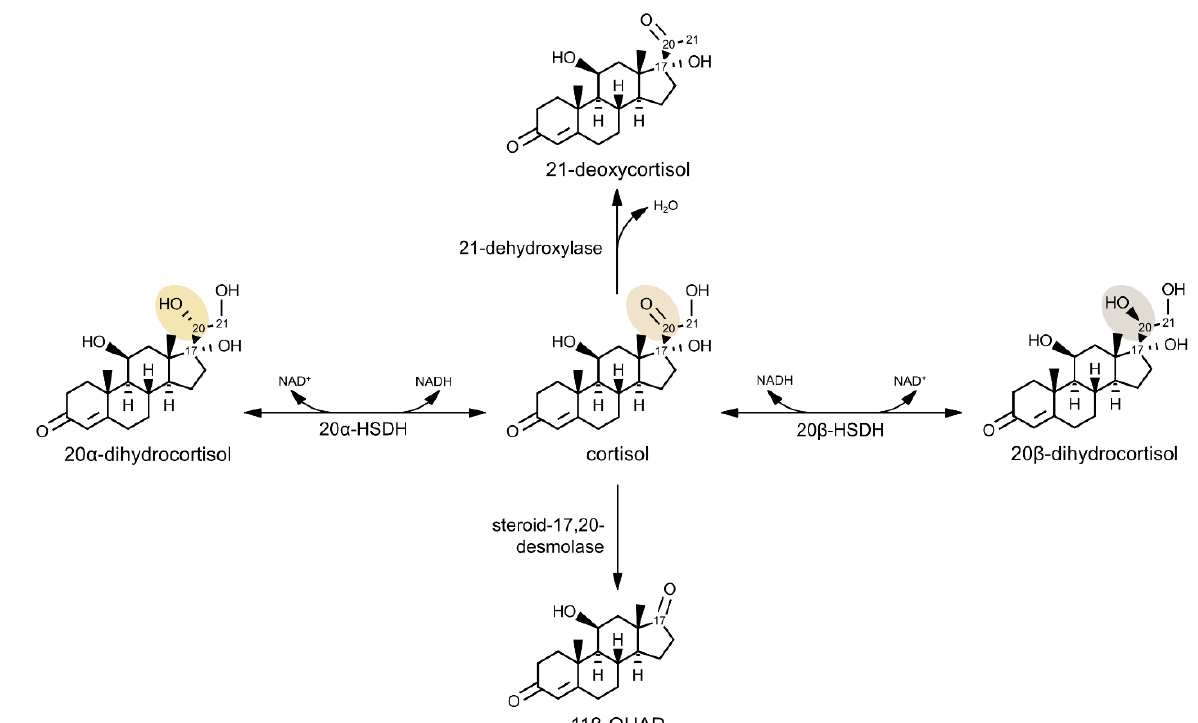
Figure 5. Microbial cortisol hydroxysteroid dehydrogenase metabolism. Cortisol can be reversibly biotransformed by 20β-hydroxysteroid dehydrogenase (20β-HSDH; DesE) to 20β-dihydrocortisol, or by 20α-HSDH (DesC) to 20α-dihydrocortisol. Steroid-17,20-desmolase (DesAB) converts cortisol to 11β-hydroxyandrostenedione (11β-OHAD). 21-Dehydroxylase catalyzes conversion of cortisol to 21-deoxycortisol.